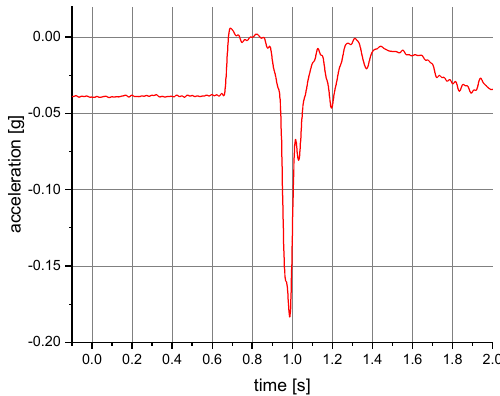
Figure 4. Acceleration as a function of time recorded during fall arrest. Test conditions: front point of the safety harness; the sensor mounted on the back of the manikin.